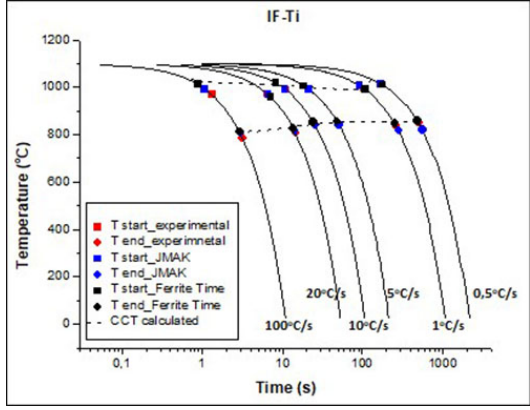
Figure 10. Comparative CCT diagrams presenting the experimental critical temperatures; the critical temperatures calculated by the JMAK method, only for the studied cooling rates (obtained from Figure 7b and Equation 4); the critical temperatures calculated by the proposed Ferrite-Time equation (obtained from Figure 7a and Equation 4); and, in addition, the final simulation applying the Ferrite-Time equation (algorithm presented in Figure